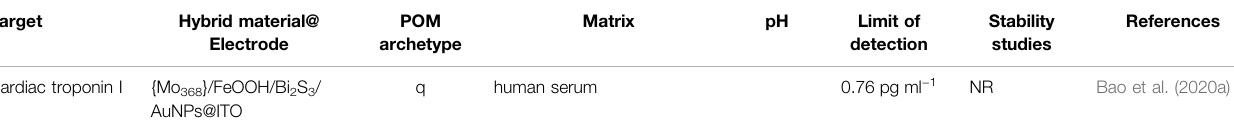
TABLE 4 | ( Continued ) POM-based electrochemical sensors for biomolecules and bio-related species.